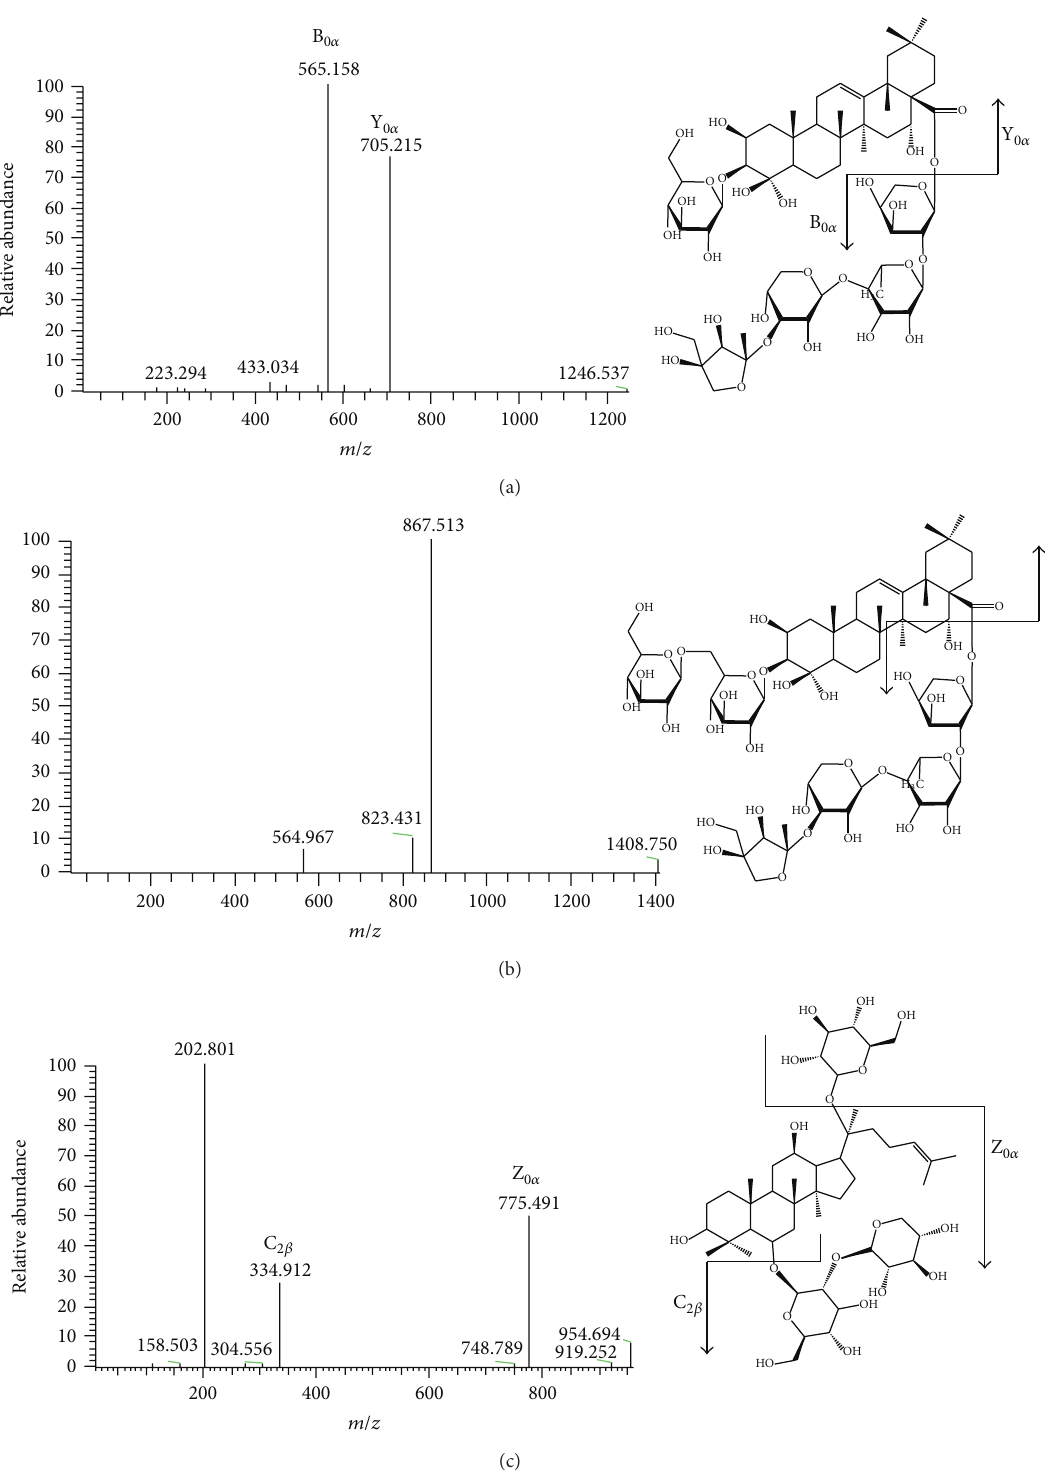
Figure 2: Product ion mass spectra used for building multiple reaction monitoring transitions for (a) PD (the precursor ion: [M+Na] + at m/z 1247.7), (b) PD3 (the precursor ion: [M+Na] + at m/z 1409.9), and (c) notoginsenoside R1 (the precursor ion: [M+Na] + at m/z